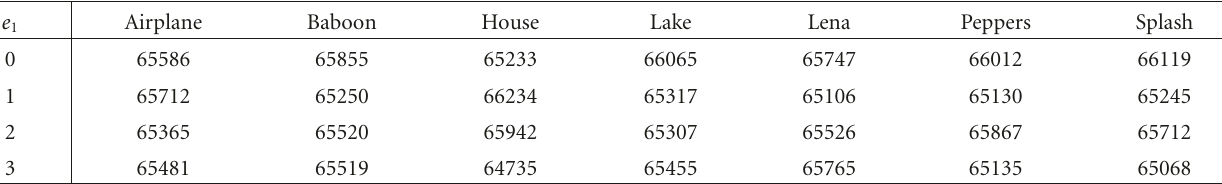
images with size 512 ×